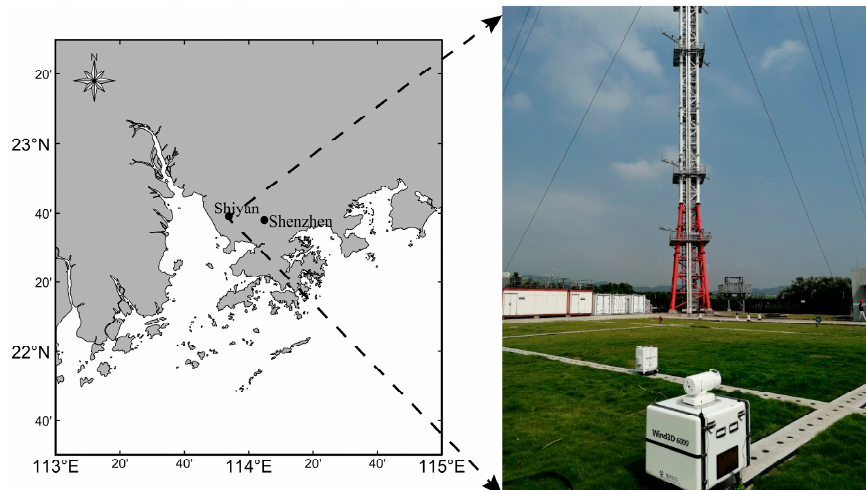
Figure 2. The geographical location and experimental apparatus. Table 1. Overview of meteorological and pollutant elements from the equipment on the tower.